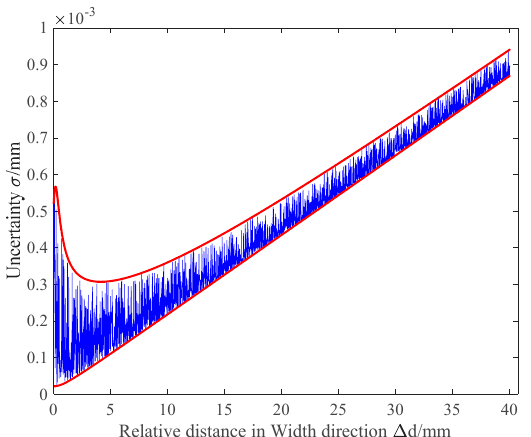
Figure 10. Uncertainty of the calibrated system from simulation. The blue line presents the uncer- tainty of measurement result, and the red line defines the envelope lines of the uncertainty.